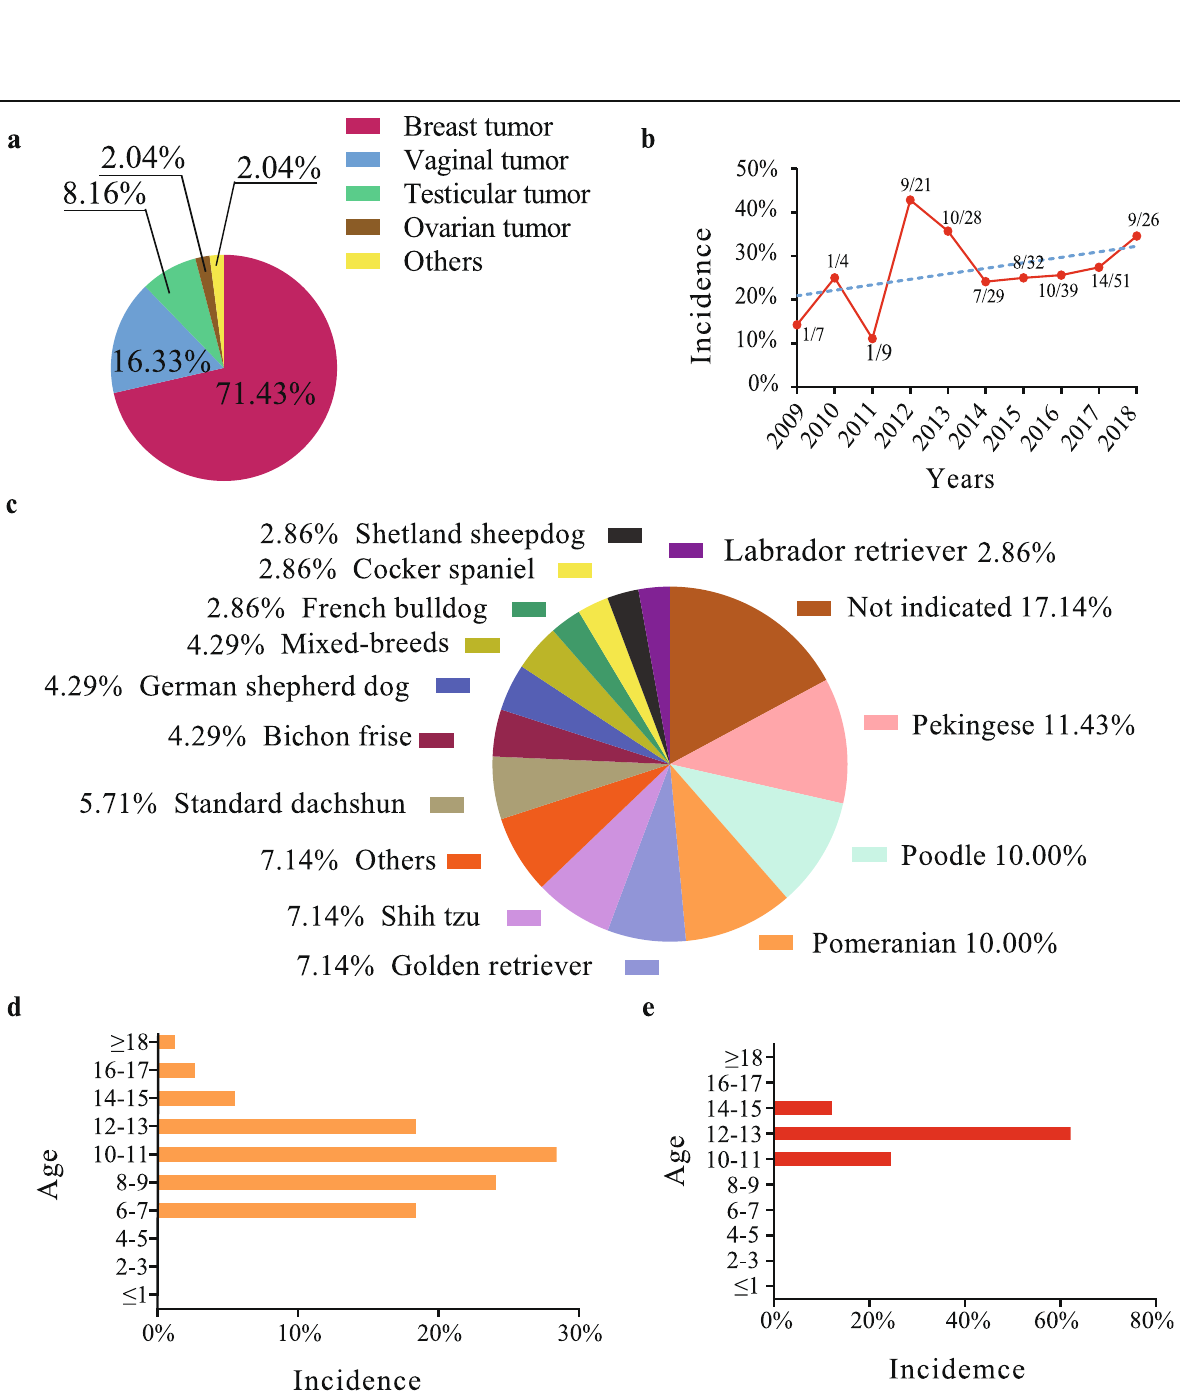
Fig. 2 Epidemiological risk of breast tumors in pet dogs by age and breed. a Proportion of different types of tumors in pet dogs ’ reproductive system. b Dynamic changes of breast tumors incidence in pet dogs from 2009 to 2018. The dotted line stands for linear regression. c Proportion of different breeds of pet dog with breast tumors. d Incidence of breast tumors at different ages. e Incidence of breast tumors at different ages in